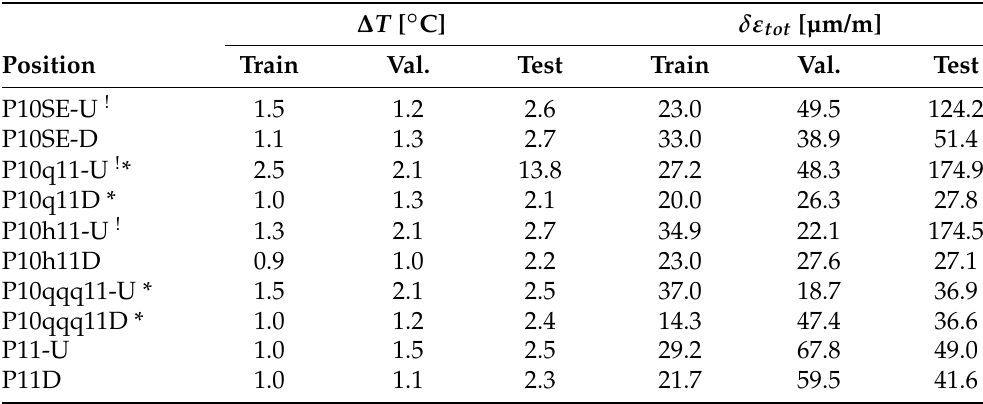
Table 2. Root mean squared prediction errors. Exclamation indicates positions with data anomaly. Asterisk indicates positions not observed during training or validation.